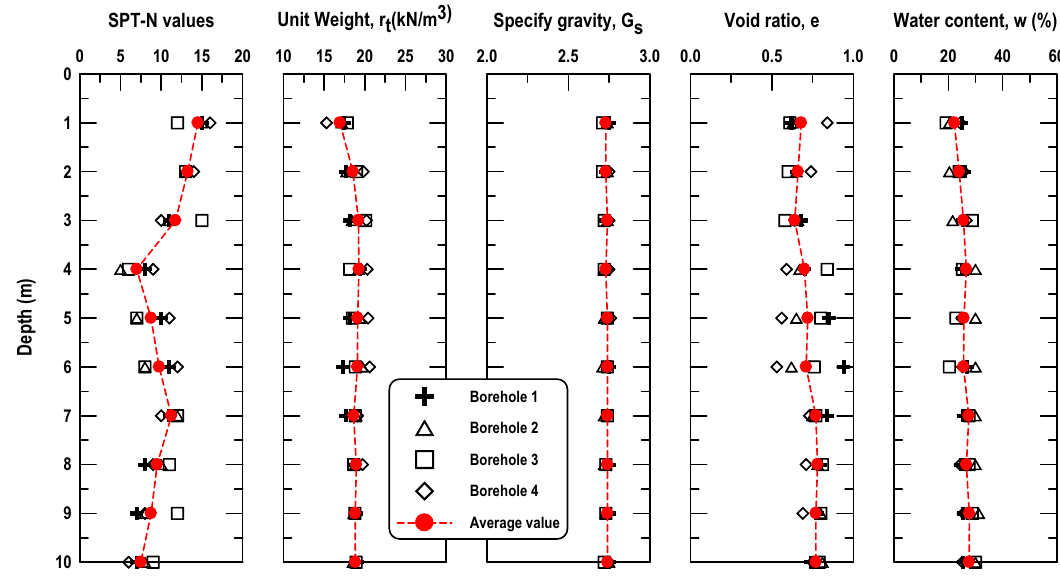
Figure 3. Soil properties of the RIC trial test site.